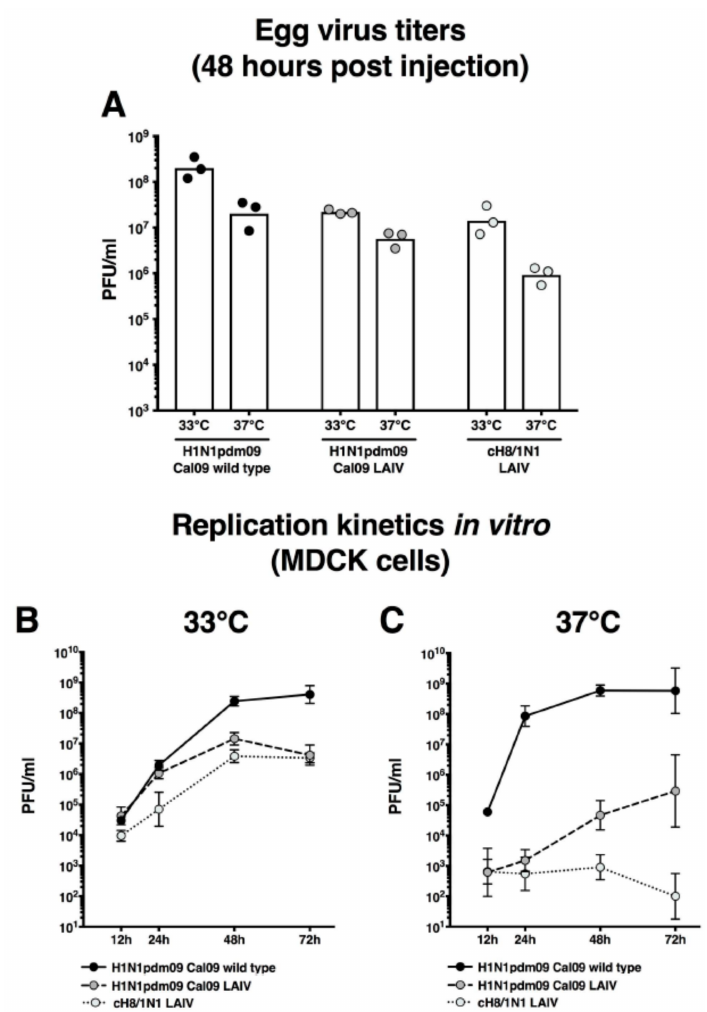
Figure 1. In vitro characterization of the LAIV virus. ( A ) Wild type pandemic H1N1 virus, an LAIV expressing the surface glycoproteins of pandemic H1N1 (dark gray circles), and an LAIV expressing cH8/1N1 (light gray circles) were grown in embryonated chicken eggs at either 33 ◦ C or 37 ◦ C. Virus titers were then determined by using a plaque assay. Each point indicates a biological replicate (individual eggs). Replication kinetics for the three viruses were assessed on MDCK cells at 33 ◦ C ( B ) or 37 ◦ C ( C ) at 12 h, 24 h, 48 h, and 72 h. Each point indicates the geometric mean of three replicates. The error bars show the 95% confidence